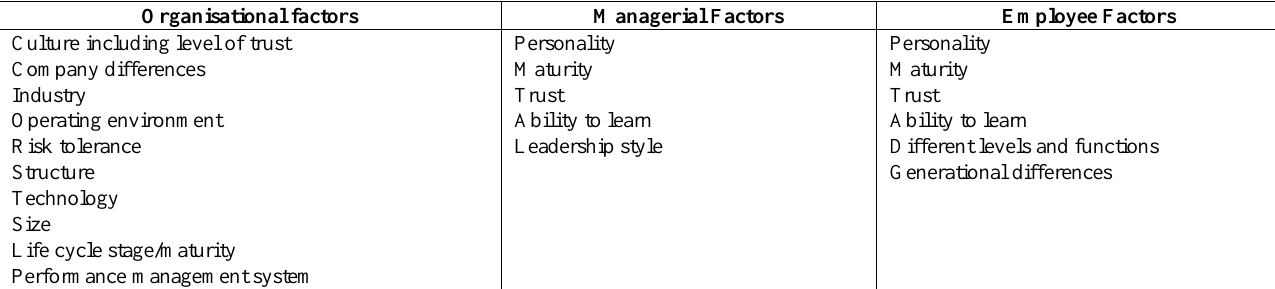
Table 2: Factors influencing the balance between autonomy and